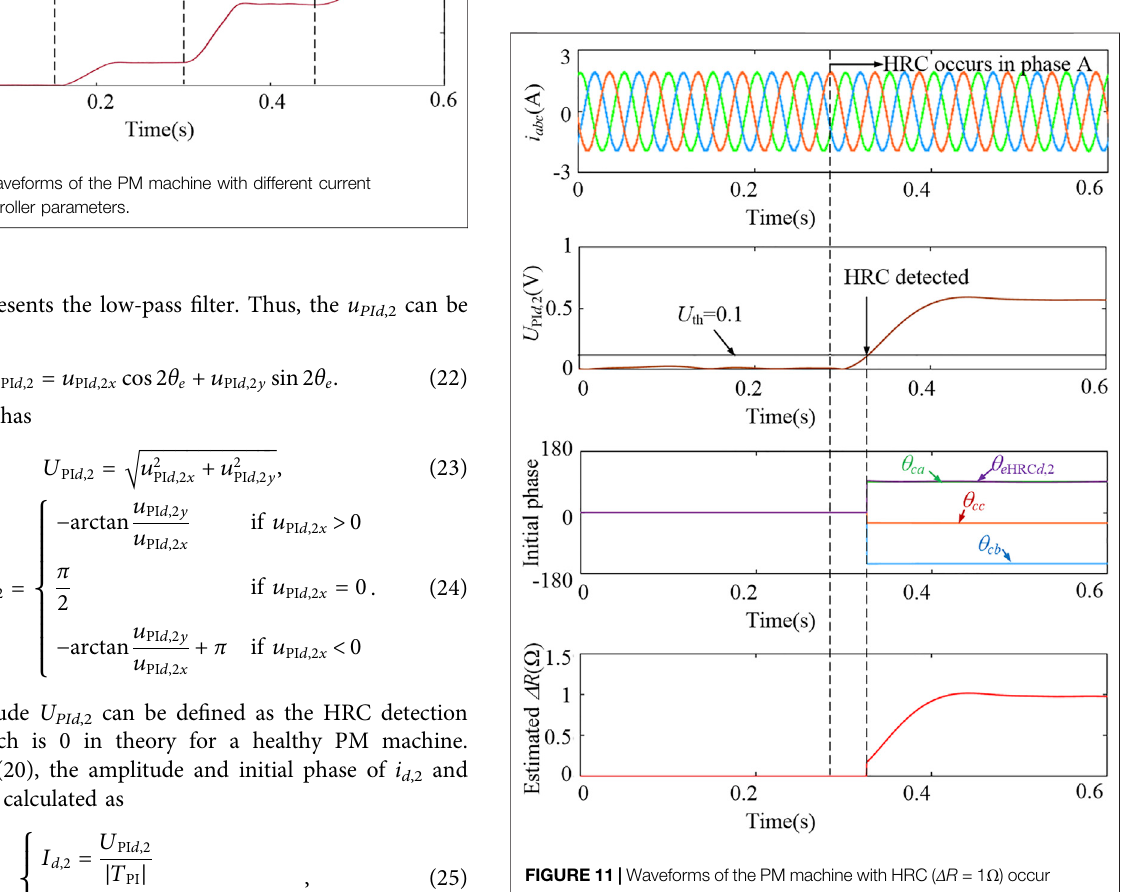
FIGURE 11 | Waveforms of the PM machine with HRC ( Δ R = 1 Ω ) occur in phase